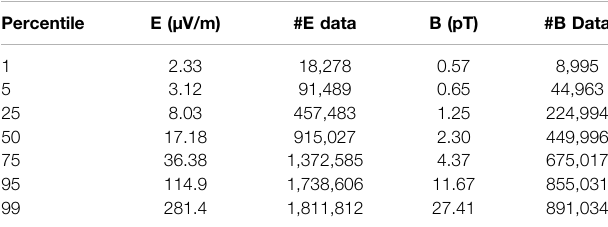
TABLE 2 | electric and magnetic fi eld threshold values and number of electric and magnetic fi eld data for a given percentile of the data.